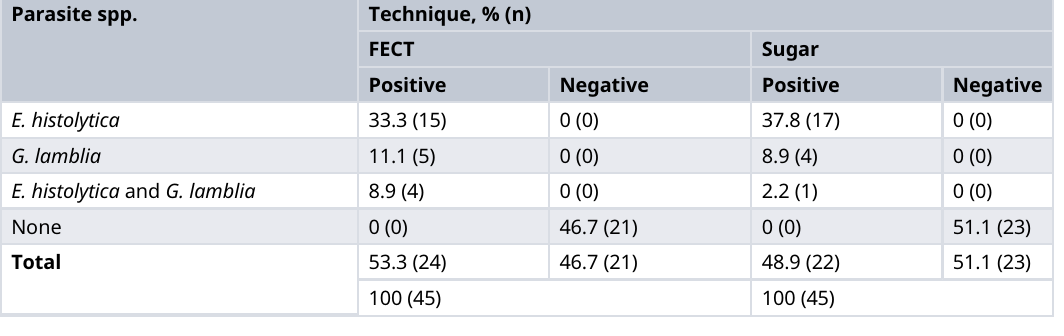
Table 2. Comparison between parasite species detected and technique used. Parasite spp.